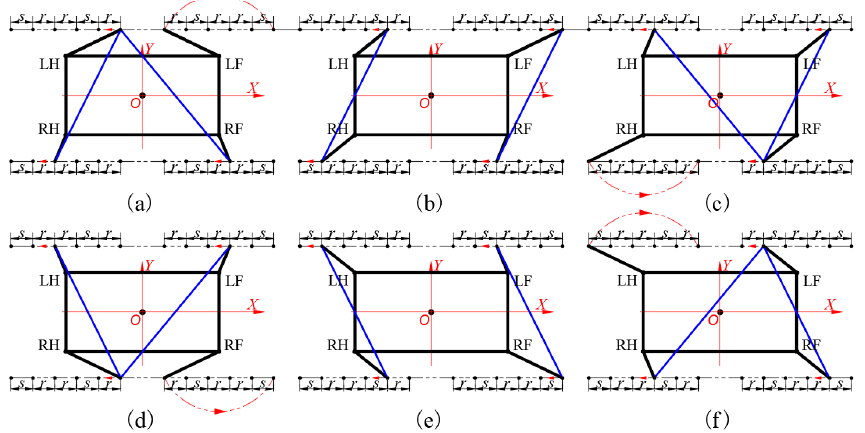
Figure 11. The relative position of the body and the ends of the four legs in the intermittent gait. ( a ) the LF has moved to the limit position, ( b ) the LF drops the ground, ( c ) the moving of RH, ( d ) the RH drops the ground, ( e ) the moving of LH,( f ) the LH drops the ground.